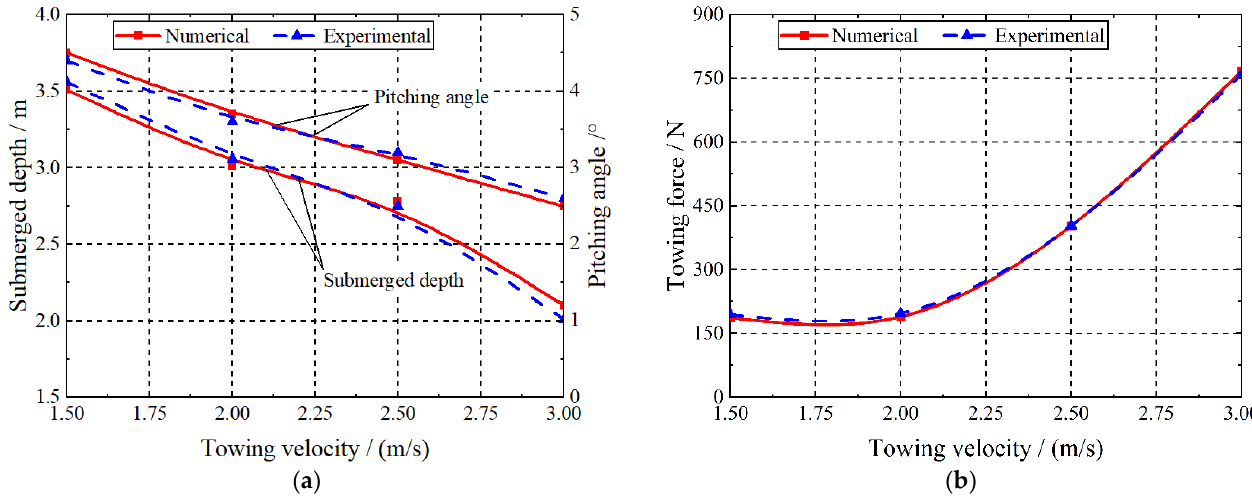
Figure 8. Steady-state numerical and experimental results: ( a ) submerged depths and pitching angles; ( b ) towing forces.